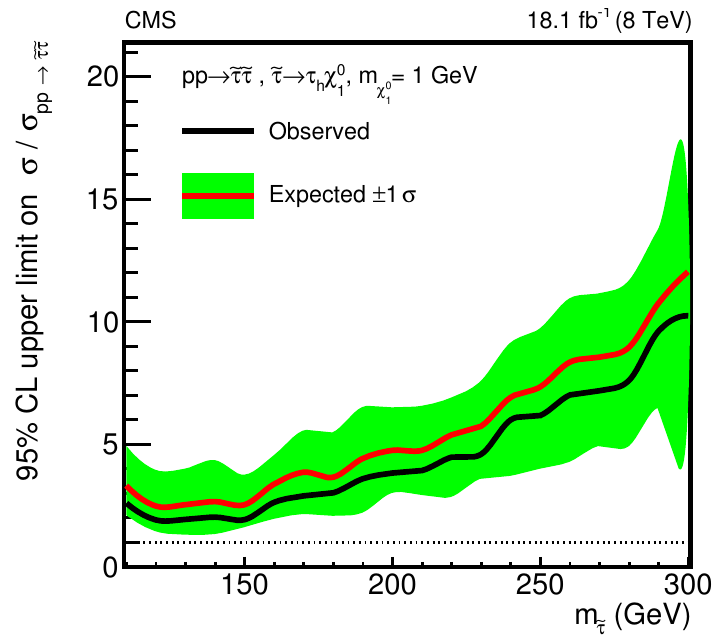
Figure 7 . Upper limits at 95% con(cid:12)dence level on the left-handed e (cid:28) pair production cross section in the (cid:28) h (cid:28) h channel. The mass of e (cid:31) 0 is 1 GeV . The best observed (expected) upper limit on the 1 cross section is 43 (56) fb for m = 150 GeV which is almost two times larger than the theoretical e (cid:28) NLO